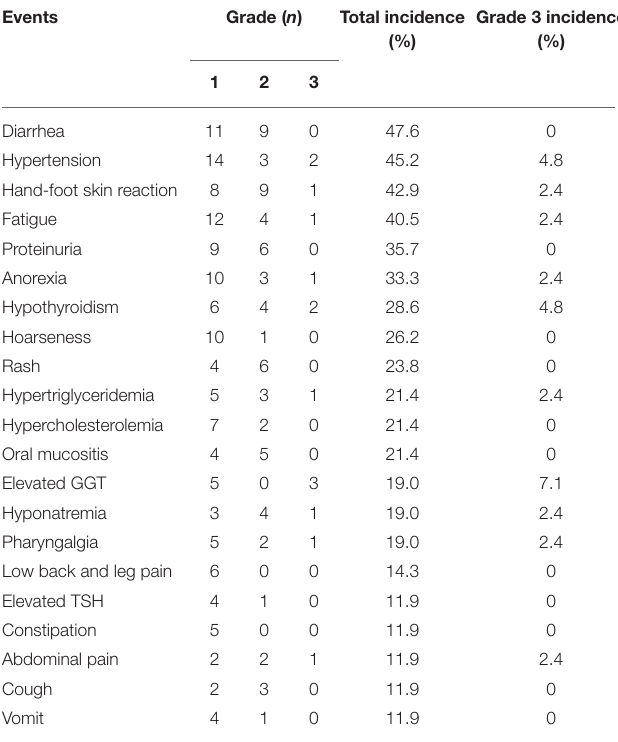
TABLE 3 | Adverse events occurred in ≥ 10% of patients